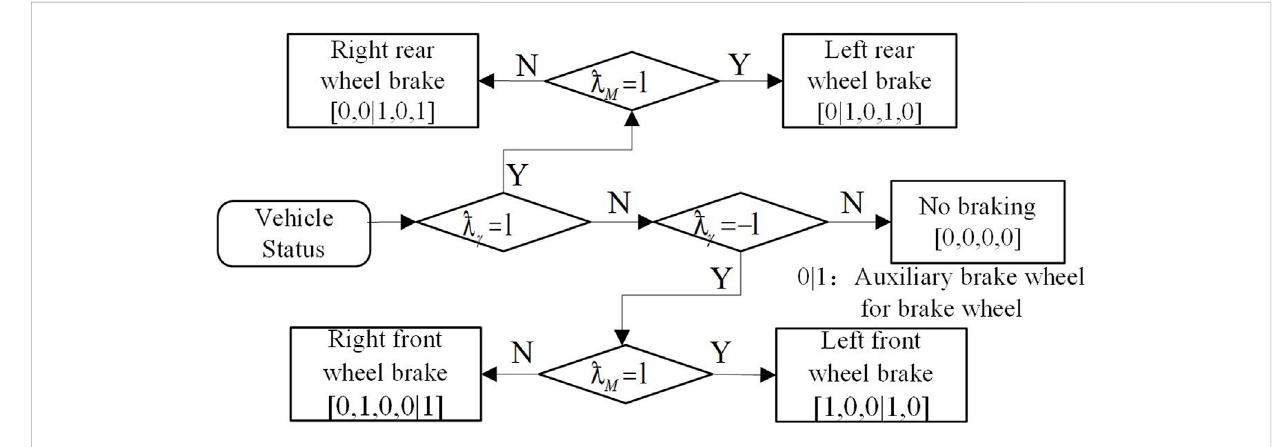
FIGURE 7 Tire selection strategy.